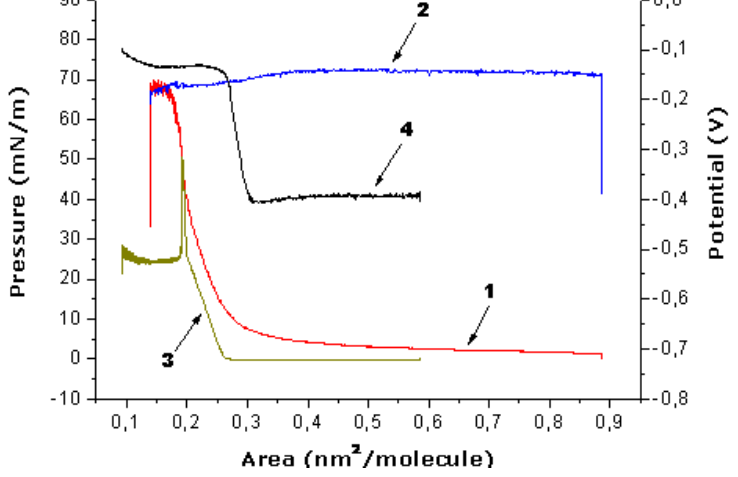
Figure 10. Dependence of surface pressure vs. monolayer area (1, 3) and surface potential vs . monolayer area (2, 4) for the mixture of OMS-5:С18 = 1:2 (1, 2) or pure stearic acid (3, 4) at the subphase of 1 mM solution of 1,3-diaminopropane